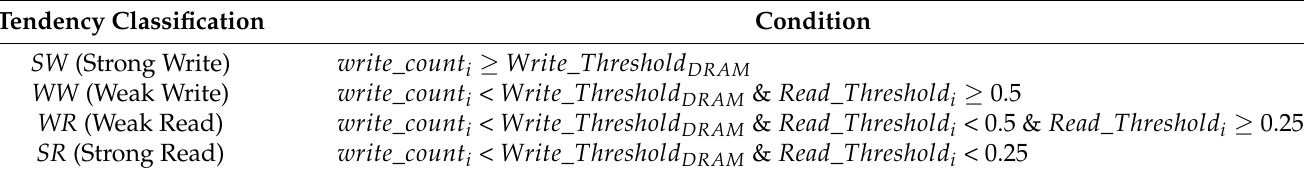
Table 3. Classification of the page access tendency of DRAM pages and their conditions. Tendency Classification